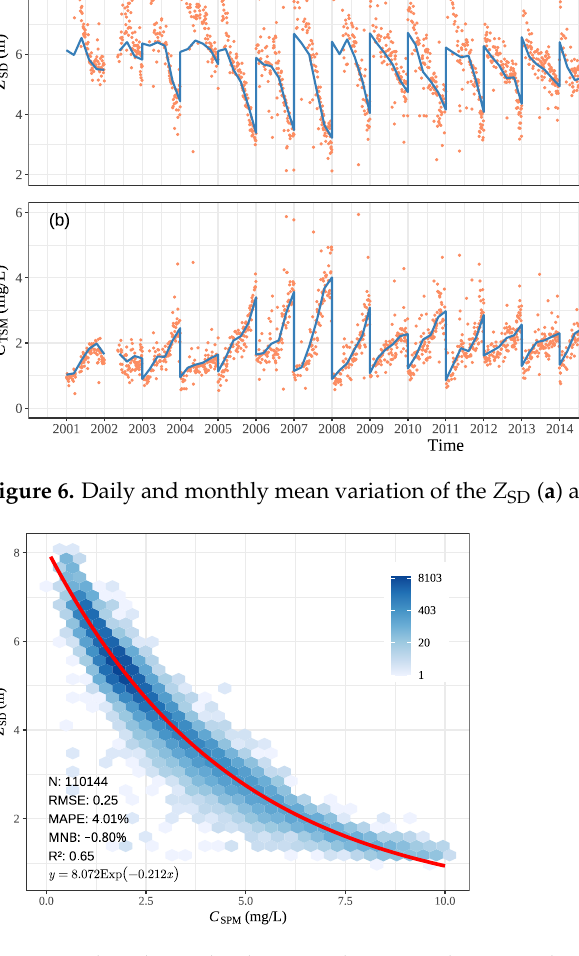
Figure 7. The relationship between the Z SD and C SPM with remote sensing estimation (the red line is the regression